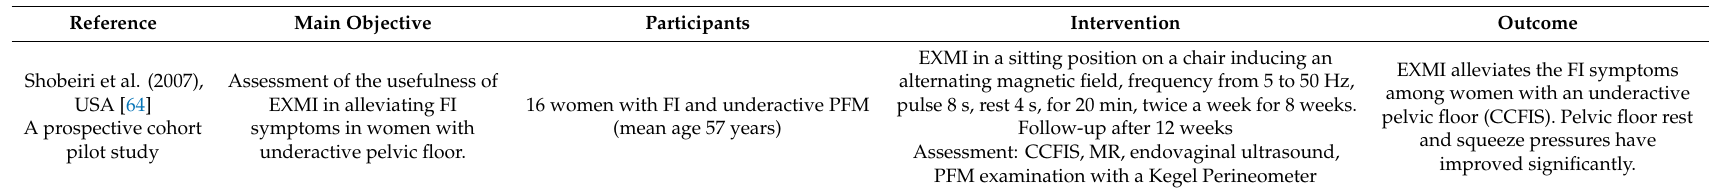
Table 8. Characterization of the e ff ects of magnetic stimulation (MS) on the severity of fecal incontinence symptoms in